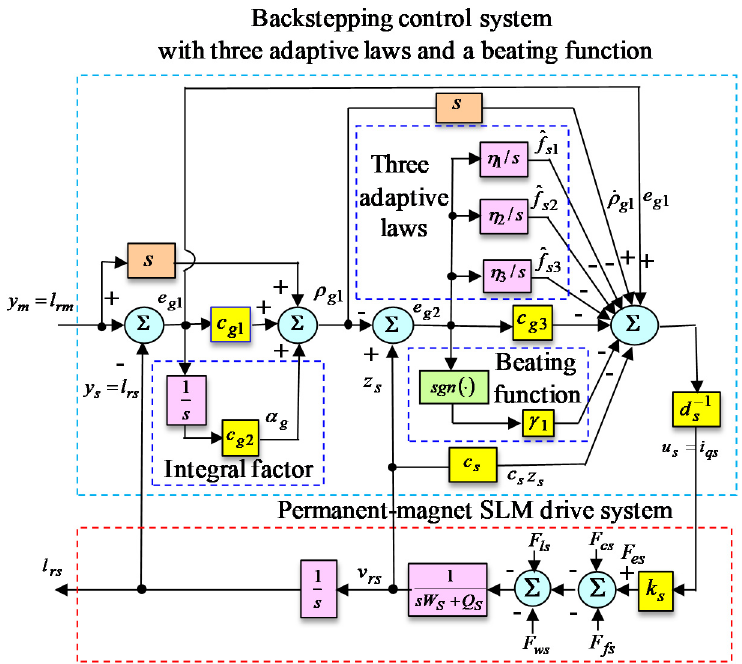
Figure 3. Block diagram of the backstepping control system with three adaptive laws and a beating function.